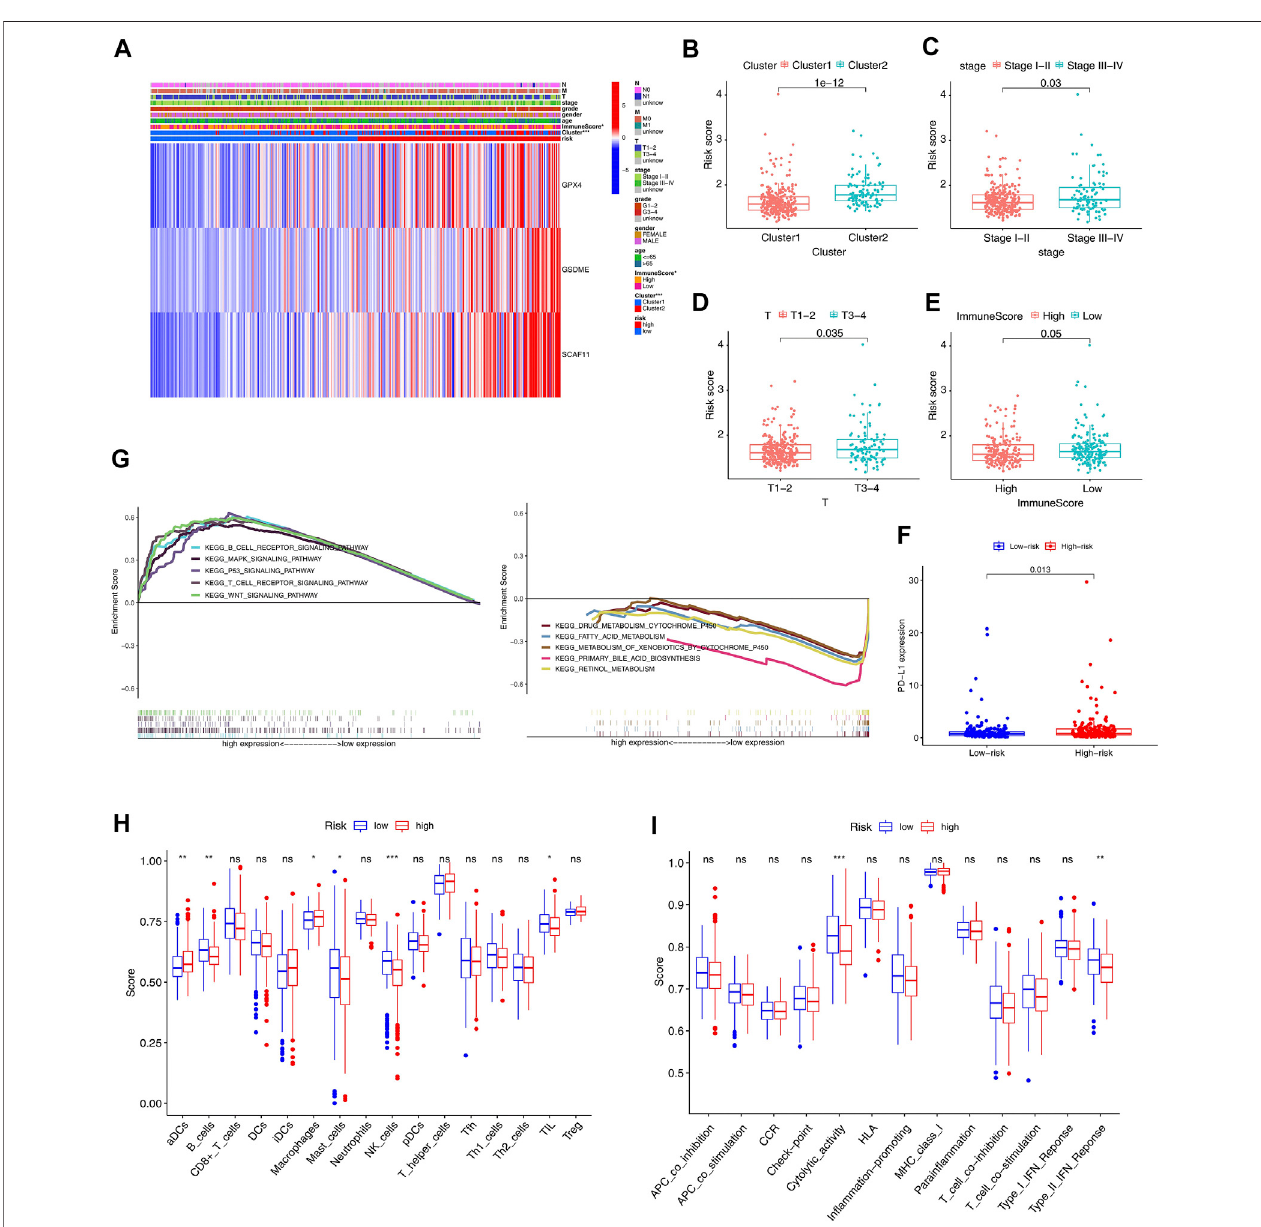
FIGURE8| GSEAand immune correlation analysisoftheimmune cellsandrelated immunepathwaysintheTCGA cohort. (A) Heatmap withcorrelationsbetween clinical features and risk groups (* p < 0.05). For T, M, N, stage, and grade, the higher the numbers, the more advanced the tumors. For cluster, cluster 1 and cluster 2 weredivided basedon consensus clusteringmodel. Theriskand ImmuneScoreweredivided intohigh and lowbased onthemedian ofall patients. (B – E) Risk scoresof the HCC patients are classi fi ed by cluster, stage, Tstage, and immune scores. (F) PD-L1 expression in the low-risk and high-risk groups. (G) GSEA of the signi fi cantly enriched KEGG pathways in the TCGA cohort classi fi ed by independent prognostic genes. (H, I) The ssGSEA scores of 16 kinds of immune cells and 13 immune pathways (* p < 0.05, ** p < 0.01, *** p < 0.001).